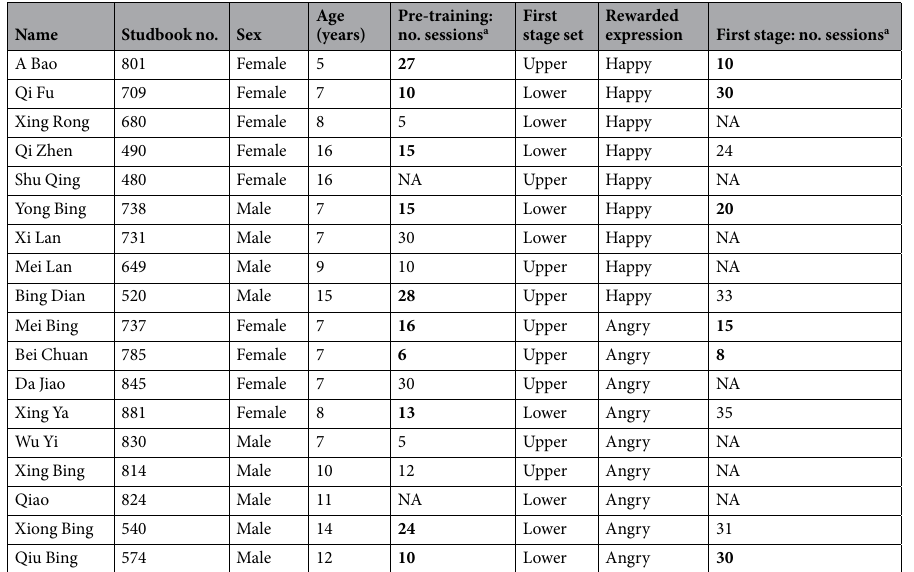
Table 1. Subjects, experimental groups and training performances. N/A: not applicable. a Bold type indicates that the learning criterion was